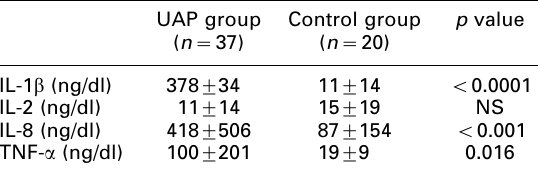
Table 2. Levels of serum IL-1 b , 1L-2, 1L-8 and TNF- a UAP group (n (cid:3) /